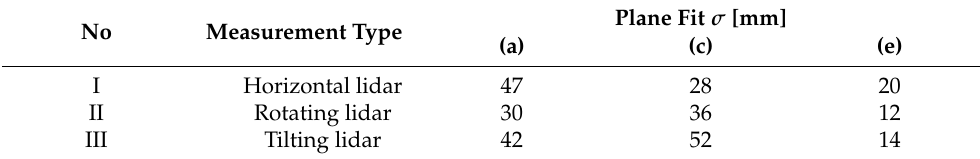
Figure 20. Point cloud surface variation comparison—object (f). Table 2. Standard deviations of the least-squares plane fit residuals